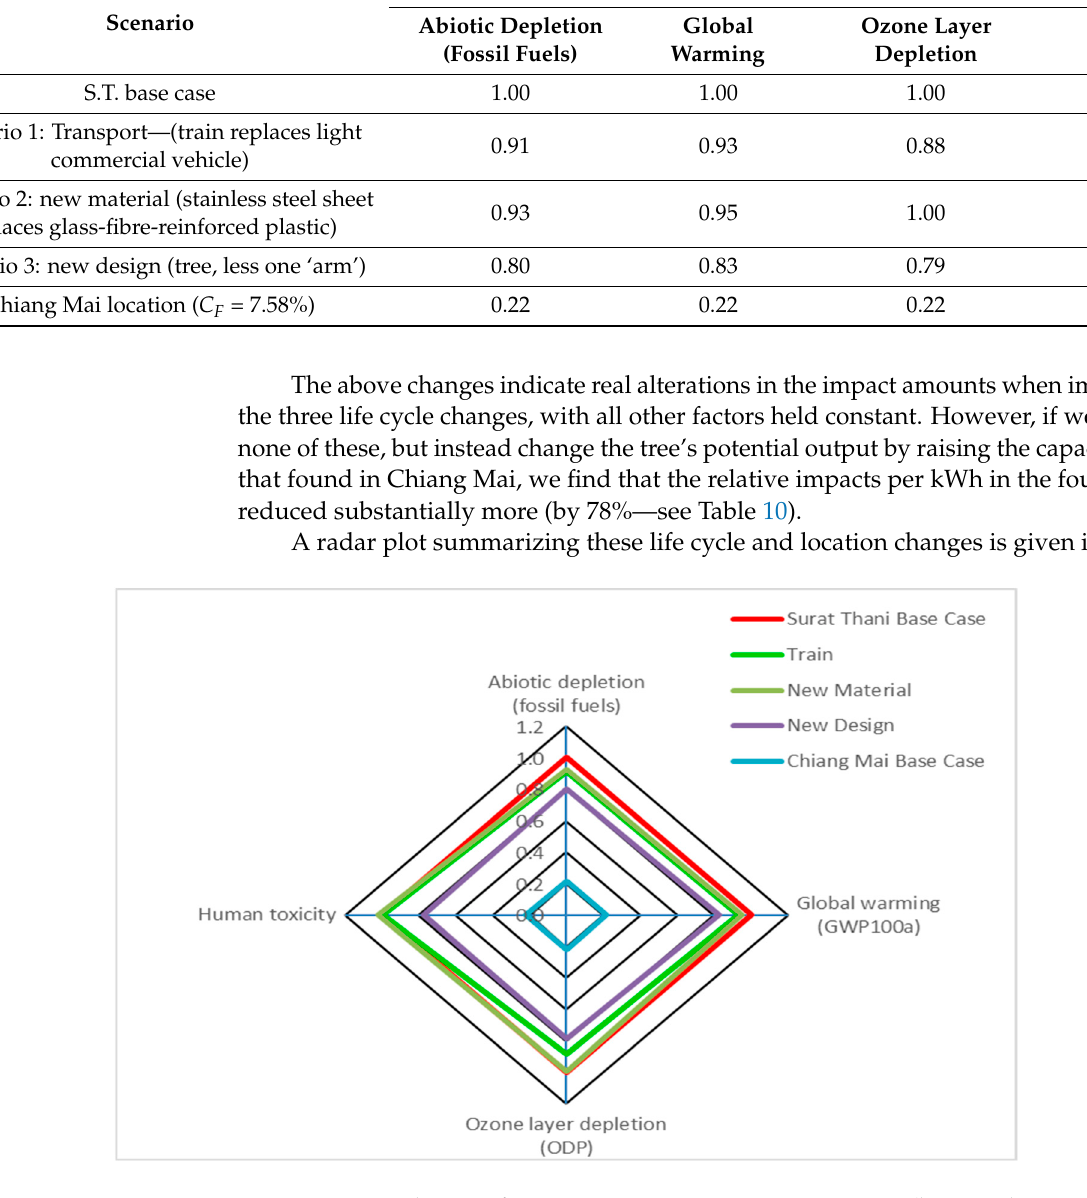
Figure 8. Impact changes of mitigation Scenarios 1 to 3, vs. C F = 7.58% (location change to Chiang Mai).